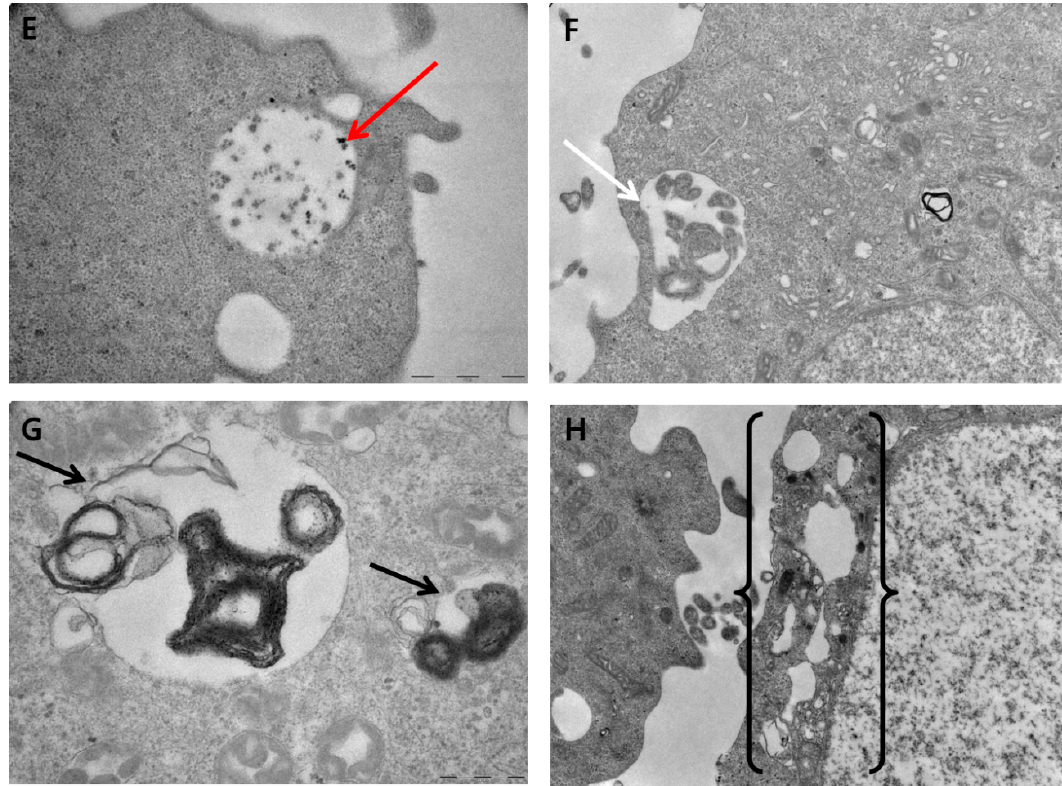
Figure 10. Palladium nanoparticles (PdNPs) induce autophagy and autophagic cell death. Autophagic ultrastructural features in human ovarian cancer cells exposed to 10 μ g/mL of PdNPs. ( A ) Control cells show typical distribution of organelles; ( B ) Internalization of PdNPs in cytoplasm of cells (red arrow); ( C ) Double-membranous phagophores developing into autophagosomes (yellow arrows); ( D ) Autophagosome (green arrow); ( E ) Internalization of PdNPs in lysosomes (red arrow); ( F ) Autolysosomes containing dead cell with electron-lucent cytoplasm and destroyed organelles, with membrane-bound cytoplasmic material (white arrow); ( G ) Fusion of autophagosomes with lysosomes or endosomes (black arrow); ( H ) Autophagic vacuoles containing membrane-bound cytoplasmic material (long bracket).